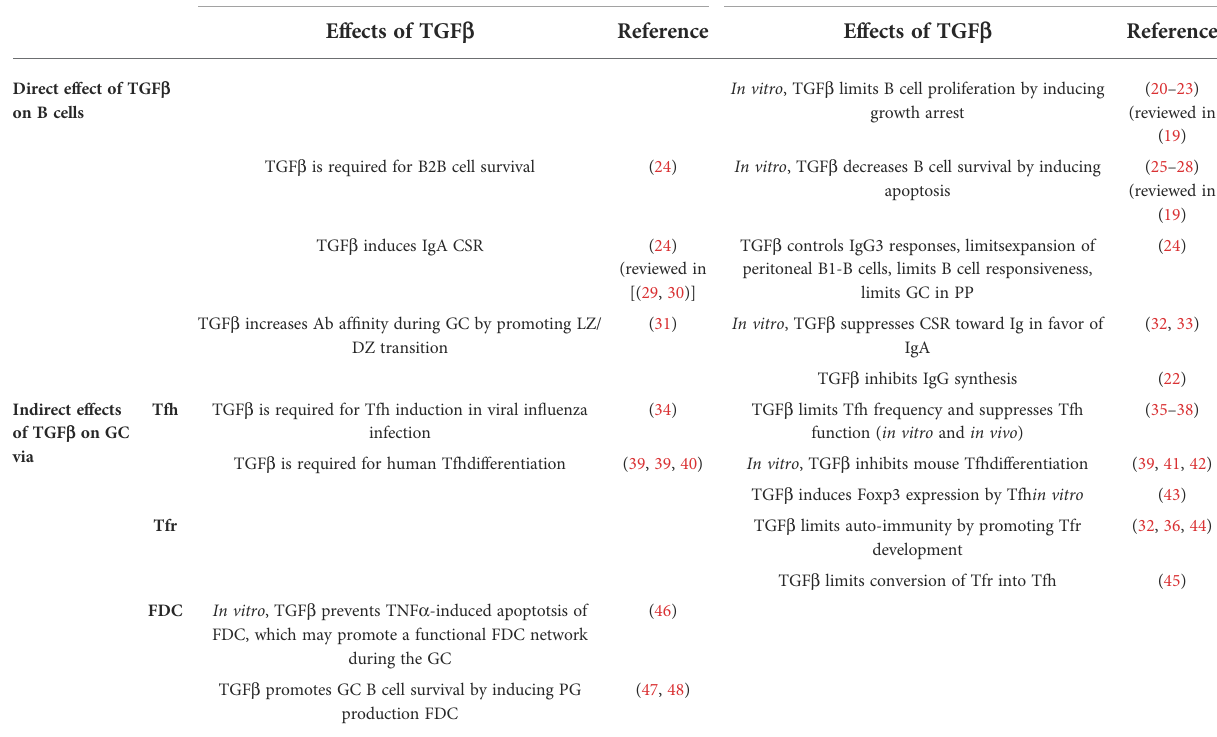
TABLE 1 Pleiotropic functions of TGF b in the regulation of humoral